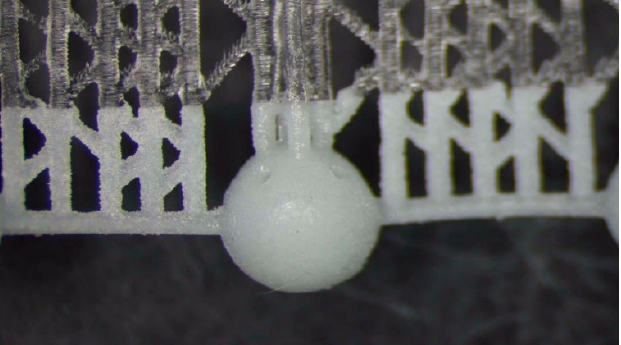
Figure 3. Vat photopolymerization: 3 mm beads built as a continuous chain and supported by a trabecular structure. Table 2. Geometrical characteristics of the beads produced by vat photopolymerization.